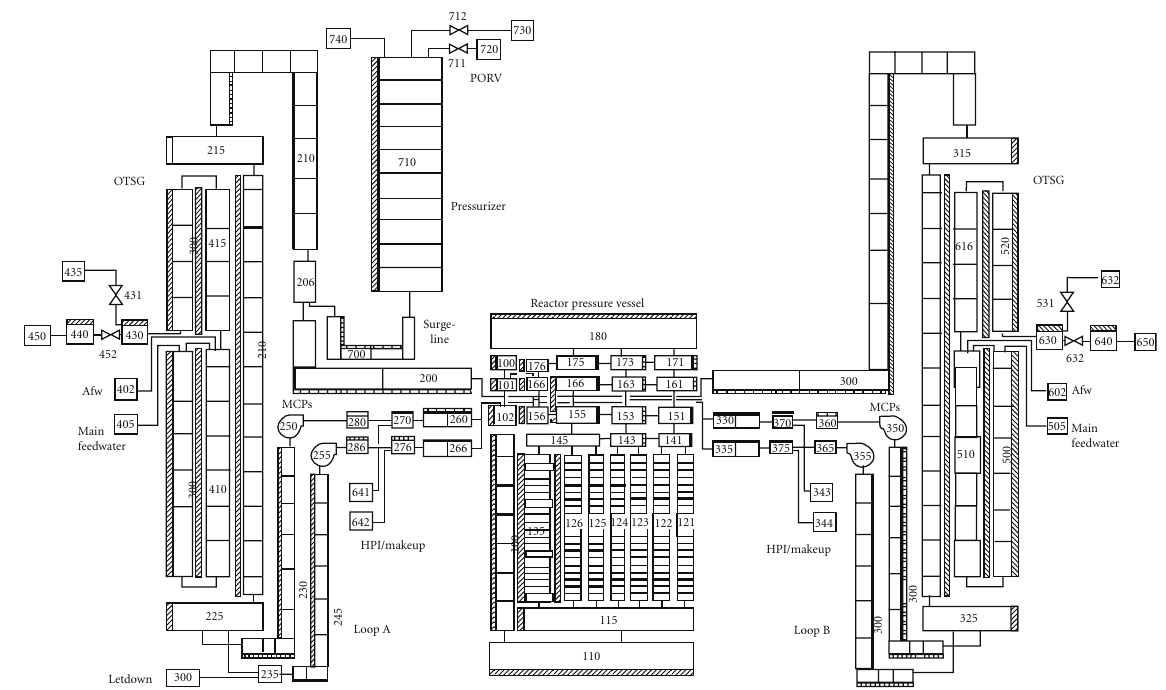
Figure 7: TMI-2 nodalization used for RELAP/SDAPSIM and SCDAP/RELAP5.